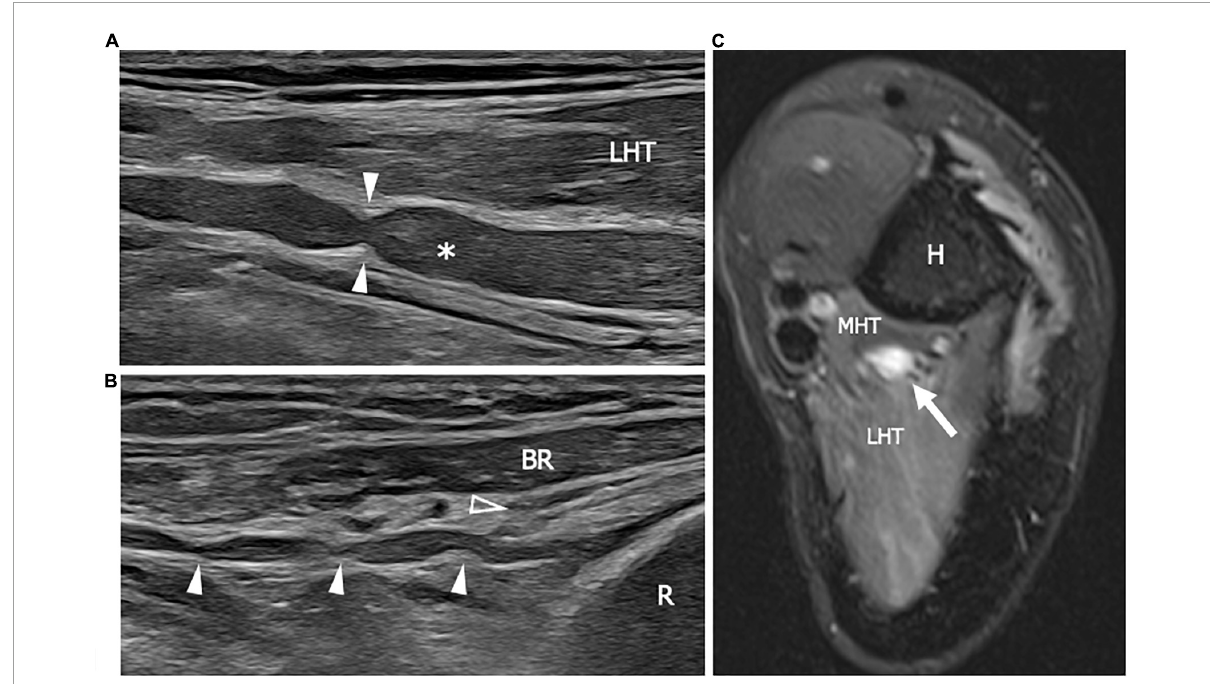
FIGURE8 This figure shows two 22 MHz HRUS images (A,B) and one T2-weighted with fat saturation axial magnetic resonance image (C) in a 41 years old patient who developed a Parsonage-Turner syndrome following the vaccination against COVID-19. (A) The radial nerve (white asterisk) is seen in its long axis. The nerve results enlarged with a focal stricture (white arrowheads) along its course, deep to the lateral head of the triceps, proximal to the humerus spiral groove. The stricture is a sign of a torsion neuropathy, typically described in association with Parsonage-Turner syndrome. Multiple narrowing points (white arrowheads) can be observed also along the posterior interosseous nerve (PIN) course in (B) . The long axis view of the PIN shows the pathological alterations in the nerve tract proximal to the Frohse arcade or the supinator arch (empty arrowhead) which represents the likely fixation point predisposing to PIN torsion. (C) The radial nerve appears enlarged with an increase T2-signal as a consequence of intraneural edema. Notice the slight T2-signal hyperintensity of the lateral head and medial head of the triceps (LHT and MHT, respectively) related to muscle denervation. H, humerus; R, radius; BR, brachioradialis